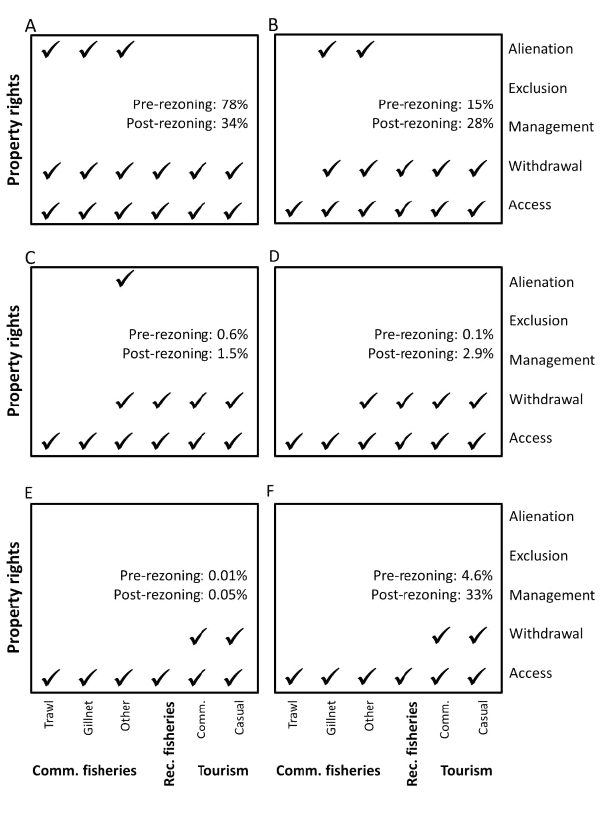
Fig. 4. Property rights by Great Barrier Reef Marine Park zone, with zones ordered from least restrictive to most restrictive. (A) General use zone: allows reasonable use, including extraction. (B) Habitat protection zone: allows some extractive use. (C) Conservation park zone: allows some extractive use. (D) Buffer zone: limited extractive use. (E) Scientific research: no extractive use except some scientific sampling. (F) Marine national park zones: no extractive use. A checkmark indicates the presence of a particular property right for an actor group in a zone. Percentages indicate the percent area in each zone pre- and post-rezoning. The preservation zone is not shown because none of the property rights apply (pre-rezoning area: 0.1%; post-rezoning area: 0.2%). Property rights did not change within zones, but the proportion allocated to different zones changed with rezoning. Withdrawal rights for fisheries are consumptive, whereas for tourism are nonconsumptive. Alienation rights for commercial fisheries are only related to being able to sell individual transferable quotas.